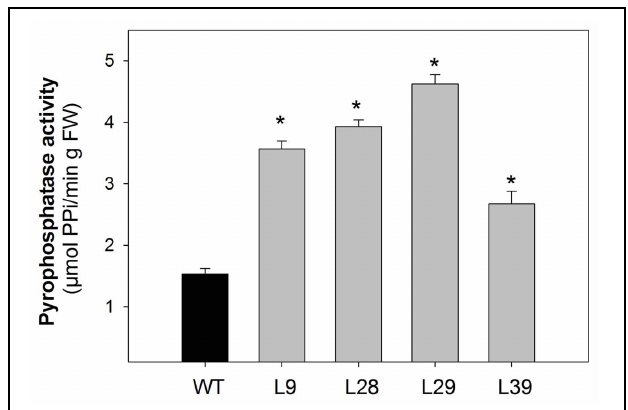
FIGURE 1 | Pyrophosphatase activity of B33-PPi tomato lines. Pyrophosphatase activity in red tomato fruit (60 DAP). An asterisk indicates the values that were determined by the t -test to be significantly different ( P < 0 . 05) from wild type.